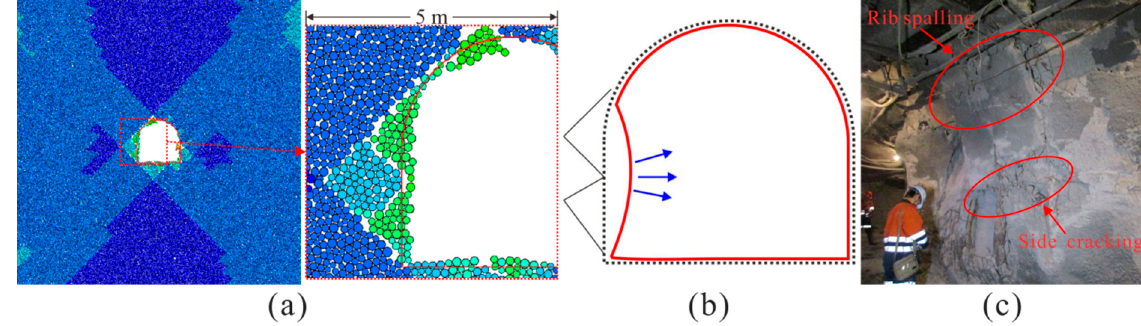
Figure 15. Schematic diagram of extrusion failure. ( a ) Numerical simulation result; ( b ) Failure mechanism; ( c ) Field representation.